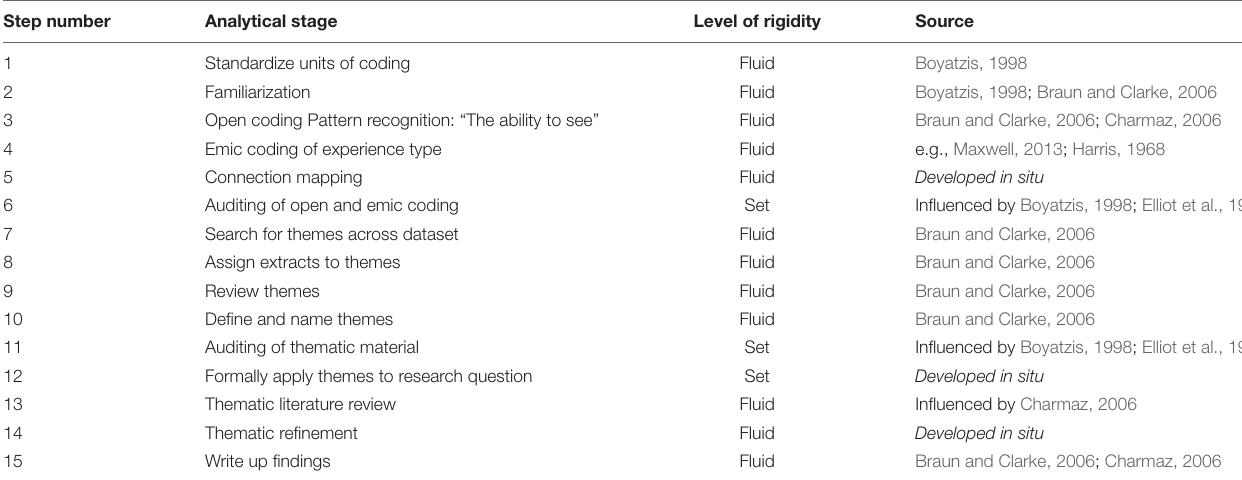
TABLE 1 | Adaptive thematic analysis